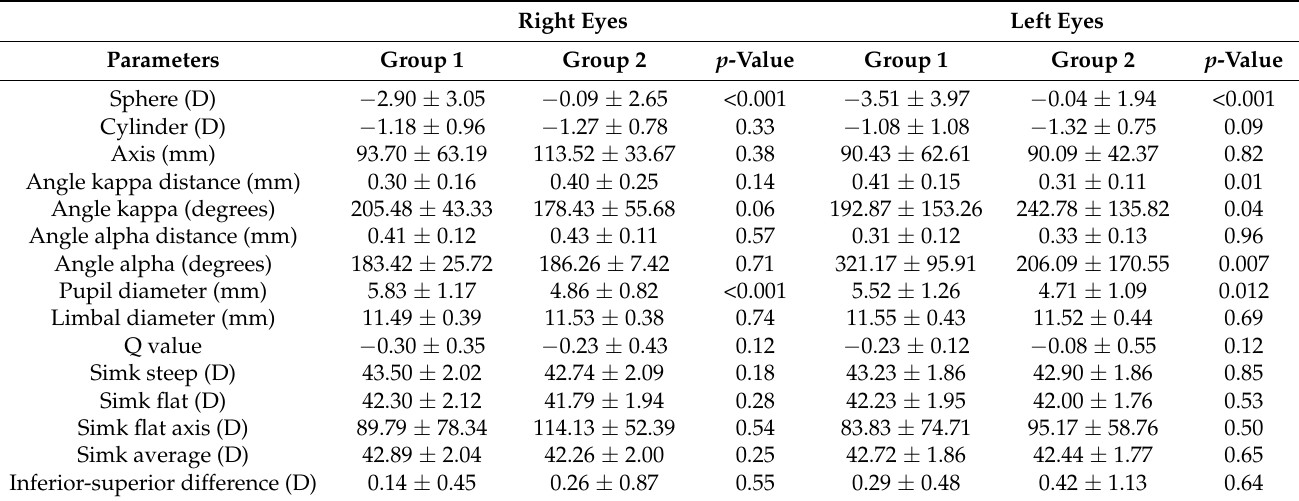
Table 1. Ocular parameters and statistical differences between subjects below 50 years (Group 1) and subjects equal or above 50 years (Group 2). Right Eyes